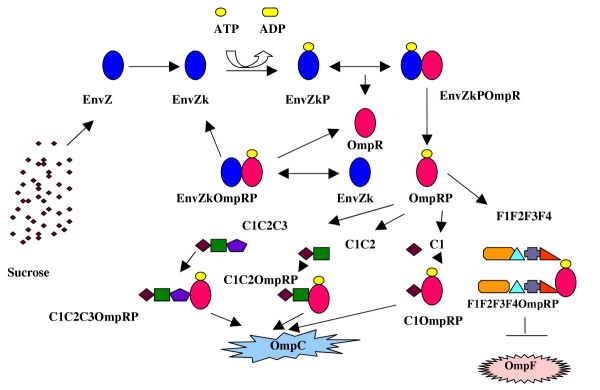
Molecular Model of Osmoregulatory switch operative at High osmolarity in Escherichia coli. With the injection stimulus of sucrose as osmolyte the sensor EnvZ is triggered to take up either kinase or phosphatase activity. In high osmolarity conditions the higher osmolyte medium (NB (Nutrient Broth)+20% sucrose) makes the kinase activity of EnvZ (EnvZk) predominate the phosphatase activity resulting in the formation of EnvZkpOmpR complex. Finally after the phosphotransfer of phosphate group to OmpR, the promoter sites of OmpF are occupied in cooperative manner with F1, F1F2 and F1F2F3, high affinity binding sites. The cellular concentration of OmpRP makes it available for the OmpC promoter C1, C1C2, C1C2C3. Additionally OmpRP binds to F4 after binding F1F2F3 promoter directly repressing OmpF expression, thereby facilitating OmpC expression.